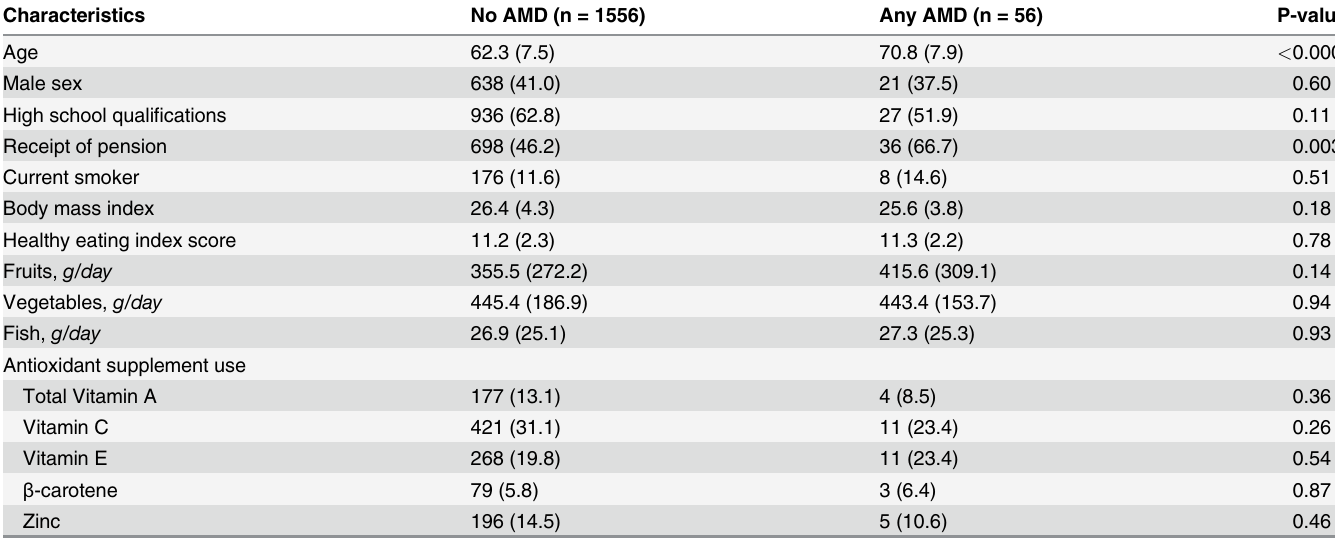
Table 1. Study characteristics of participants stratified by AMD status at baseline who were followed up at the 10-year follow up in 2007 – 9 Blue Mountains Eye Study.